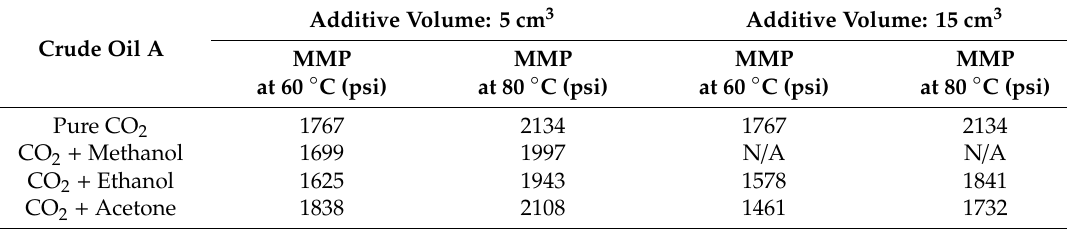
Figure 9. E ff ects of additive volumes and types on decreasing minimum miscibility pressure (MMP): ( a ) crude oil A and ( b ) crude oil B. The larger acetone volume results in more decrement of MMP values.